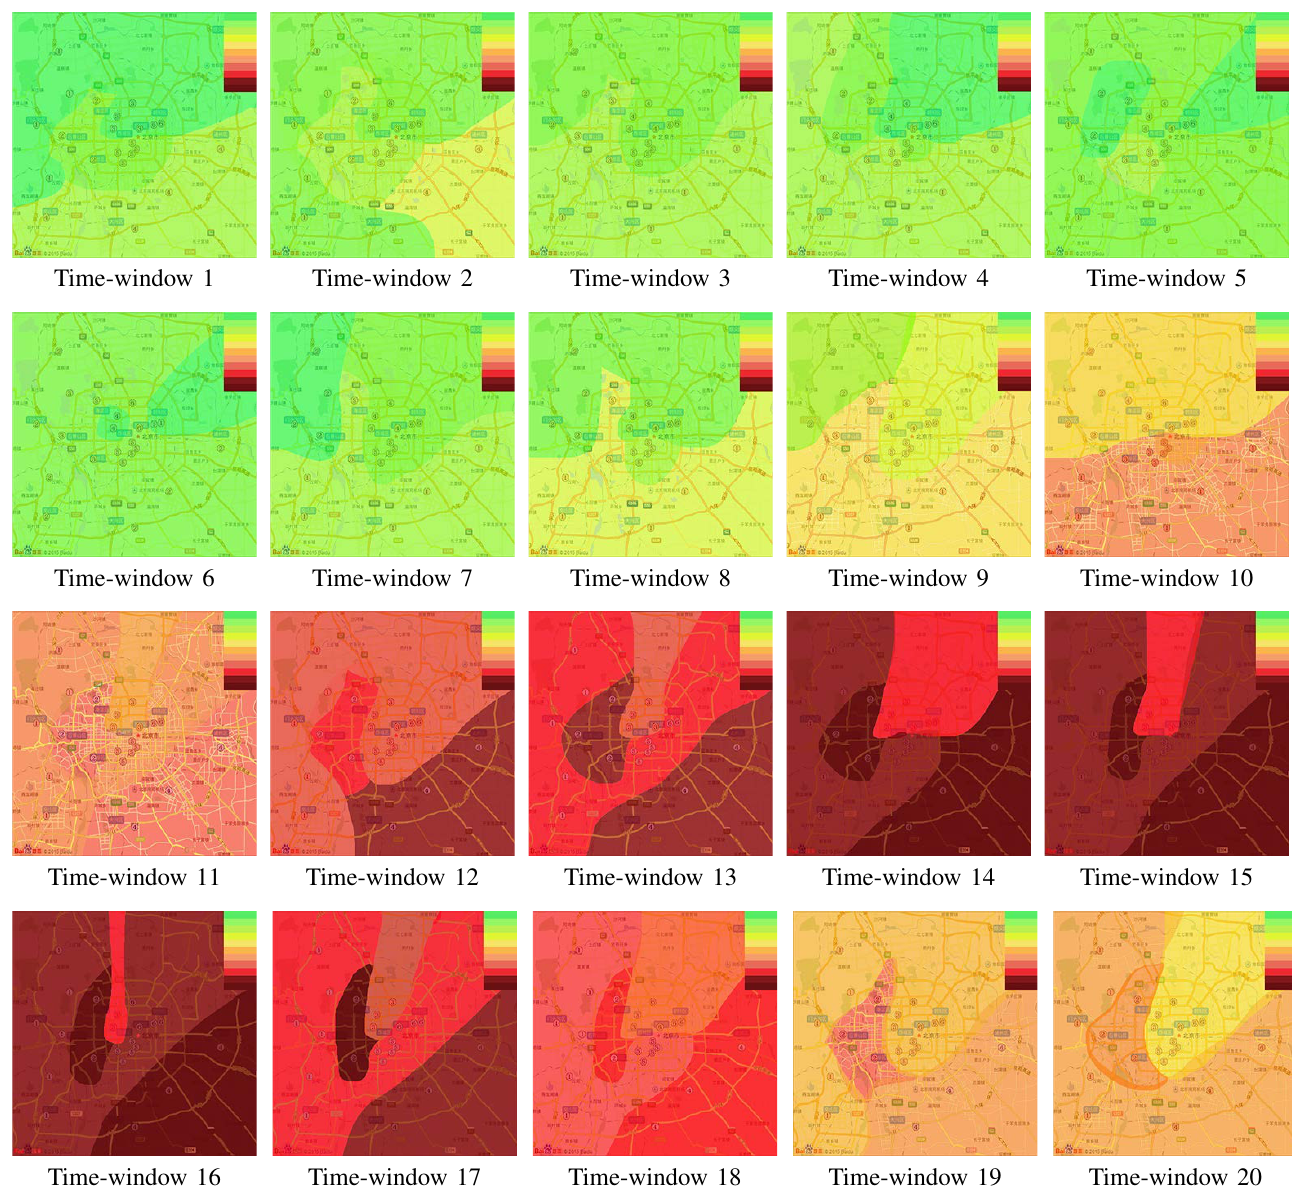
Fig.10. Pollution diffusion trends in 20